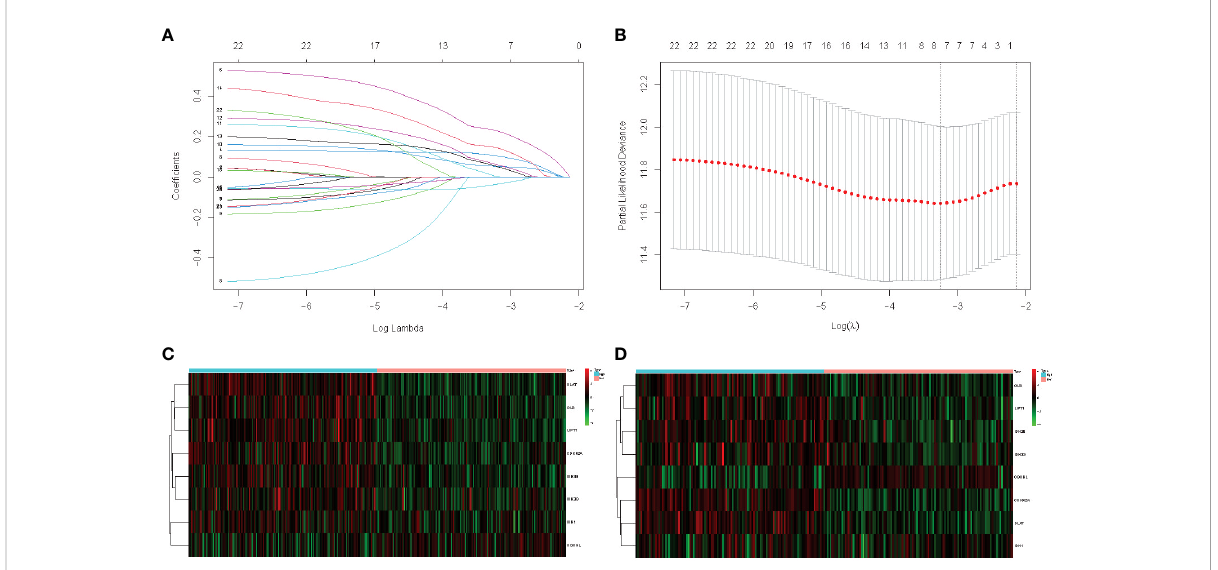
FIGURE 1 (A) LASSO coef fi cient pro fi les of the 23 cuproptosis and TCA-related genes from the TCGA cohort. (B) Partial-likelihood deviance of variables revealed by the LASSO regression signature. Red dots represent the partial likelihood of deviance values, gray lines represent the standard error (SE), and the two vertical dotted lines on the left and right represent optimal values by minimum criteria and 1 – SE criteria, respectively. (C) TCGA heatmap of the prognostic signature consisting of eight cuproptosis and TCA-related genes. (D) ICGC heatmap of the prognostic signature consisting of eight cuproptosis and TCA-related